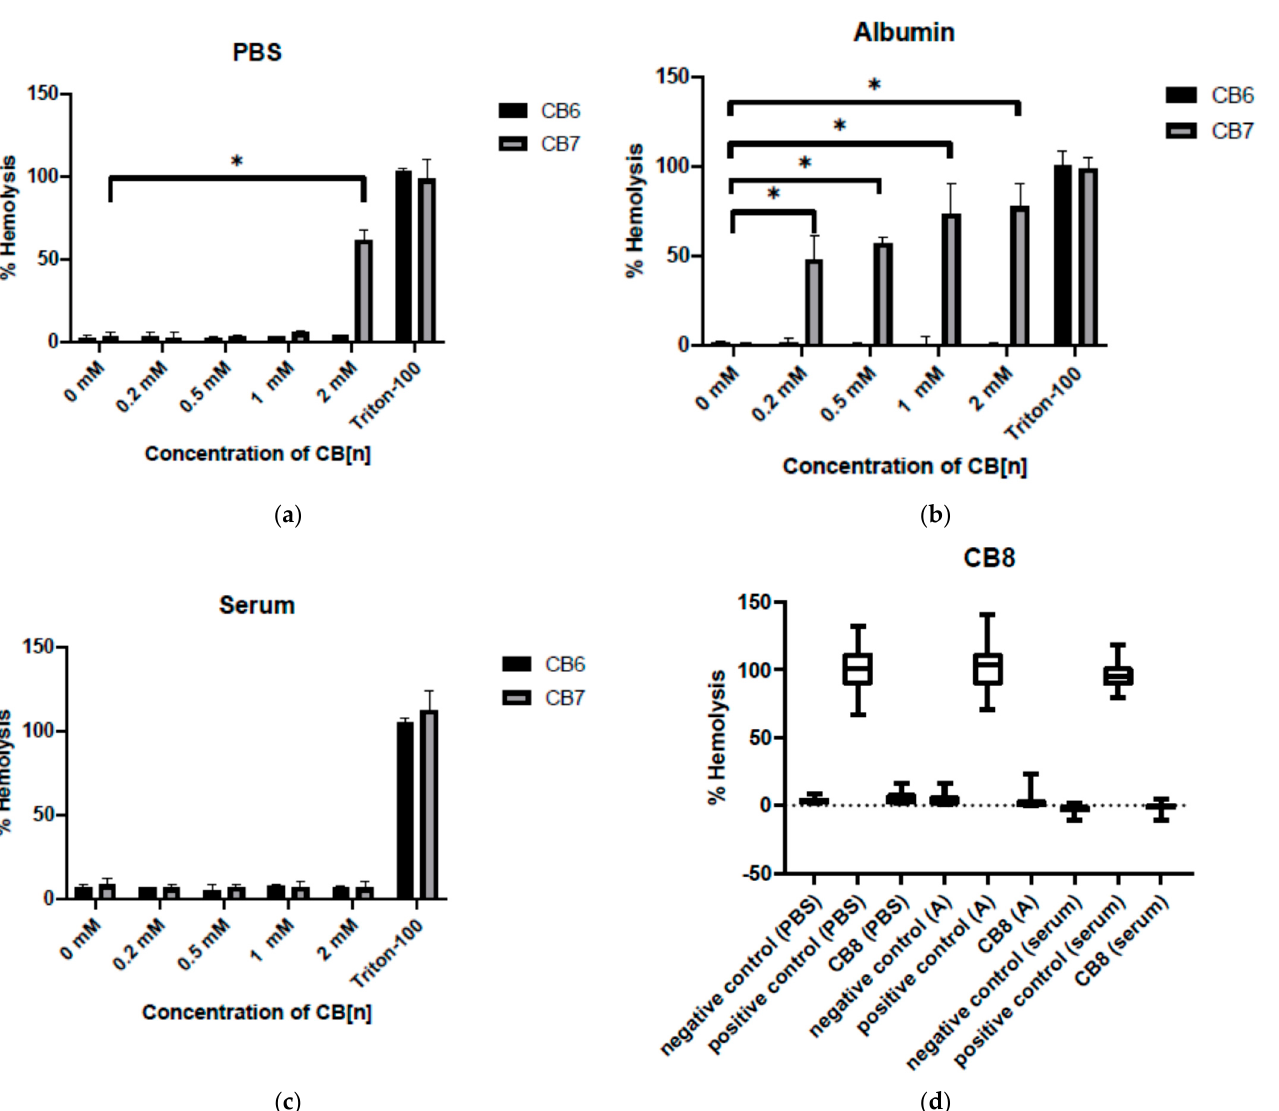
Figure 4. Effect of cucurbit[6,7,8]urils on the hemolysis of erythrocytes: ( a ) effect of CB[6] and CB[7] on the hemolysis of erythrocytes in PBS; ( b ) effect of CB[6] and CB[7] on the hemolysis of erythrocytes in albumin; ( c ) effect of CB[6] and CB[7] on the hemolysis of erythrocytes in autologous serum; ( d ) effect of CB[8] on the hemolysis of erythrocytes in different biologically relevant media. * Indicates a significant difference ( p < 0.05) vs. the control. Data are presented as the median with the interquartile range (n = 8).